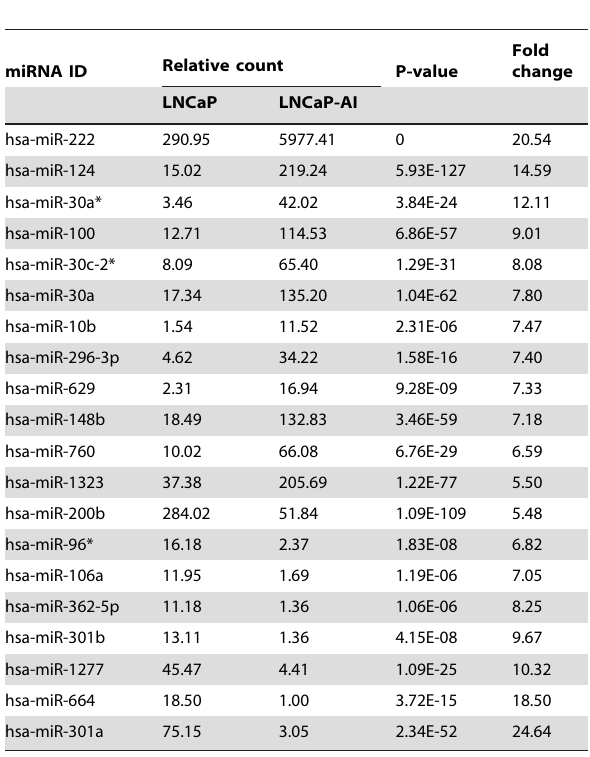
Table 1. Top 20 miRNAs differentially expressed between the LNCaP and LNCaP-AI libraries.